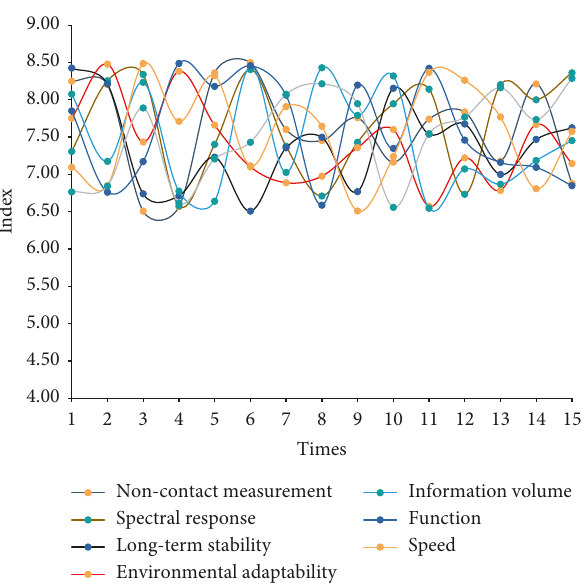
Figure 2: Machine vision system